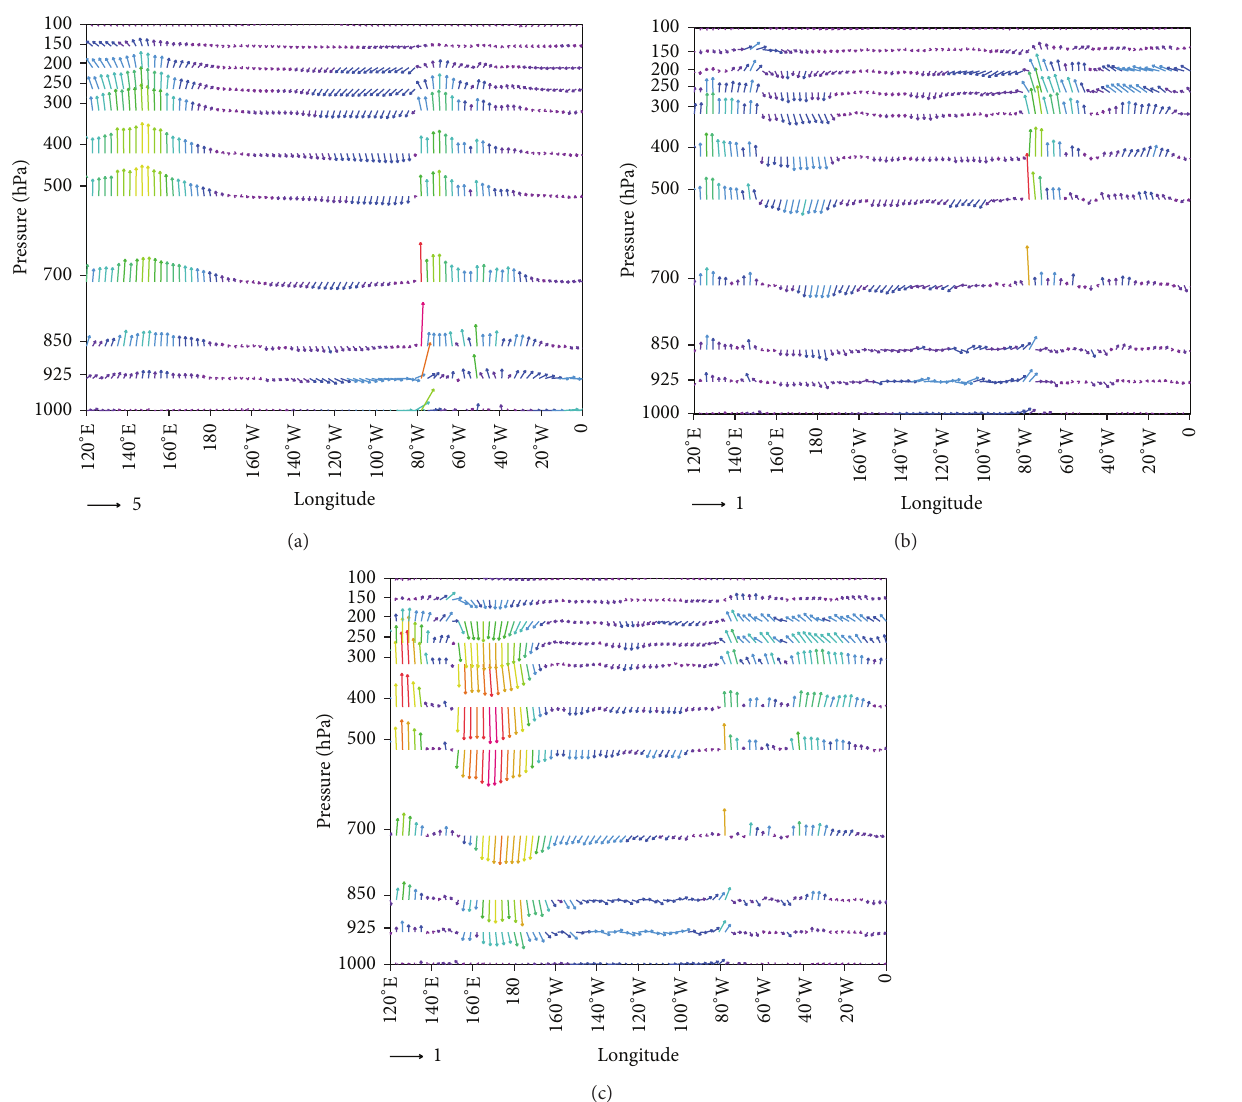
Figure 12: Walker circulation by averaging divergent wind and vertical velocity in the latitudinal band between 5 ∘ S and 5 ∘ N in the period 1996–2011 based on the Era-Interim reanalysis for (a) climatological annual mean and anomalies for (b) HCSA strong cases and (c) HCSA poleward expansion cases. The color scale represents the vector’s magnitude. The reference vector in (a) corresponds to 5m s −1 whereas in (b) and (c) it is 1ms −1